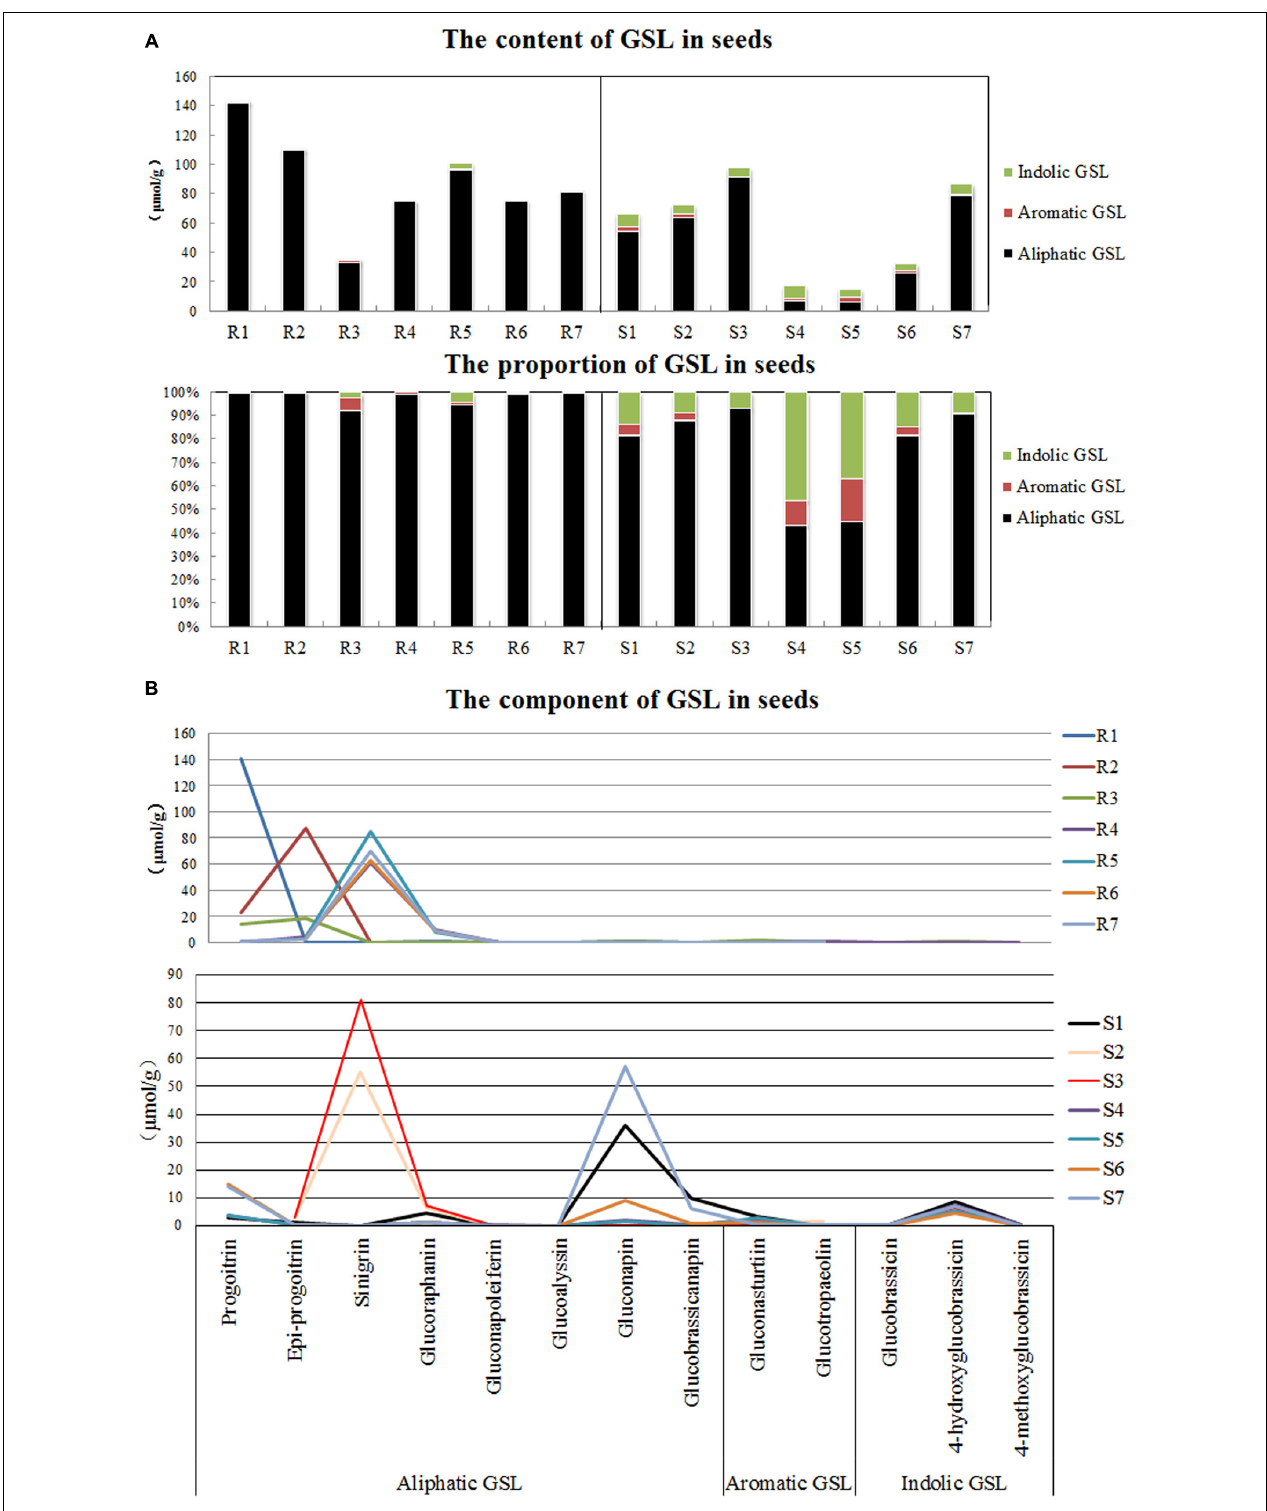
FIGURE 4 | Detection of glucosinolates (GSLs) in seeds of various disease resistance plants. (A) Contents of three types of GSLs. (B) Proportions of three types of GSLs. R1-R7 refer to the clubroot-resistant plants, and R1-R7 refer to the clubroot-susceptible plants. R1, English wallflower; R2, Violet orychophragmus; R3, Indigowoad Root; R4, Violet (Matthiola hot cakes); R5, Violet (Vintage); R6, Violet (Incana); R7, Violet (Francesca); S1, Chinese cabbage (xin 3); S2, Radish (Banyeweiqing); S3, Radish (Baiyudagen); S4, Oilseed (zhongshuang 11); S5, Oilseed (zhongyou 821); S6, Oilseed (BJ003); S7, Oilseed (BJ004).